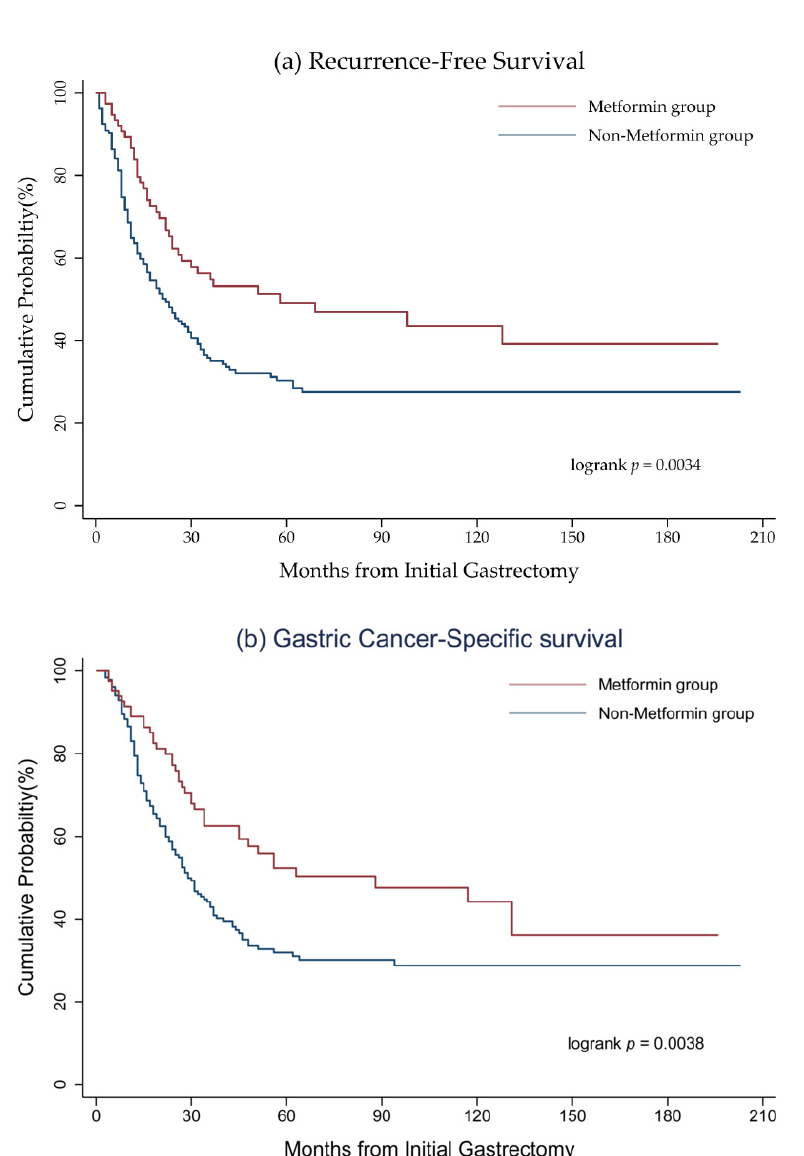
Figure 3. ( a ) Recurrence-free survival and ( b ) cancer-specific survival in patients with stage III GC and DM in terms of metformin use.